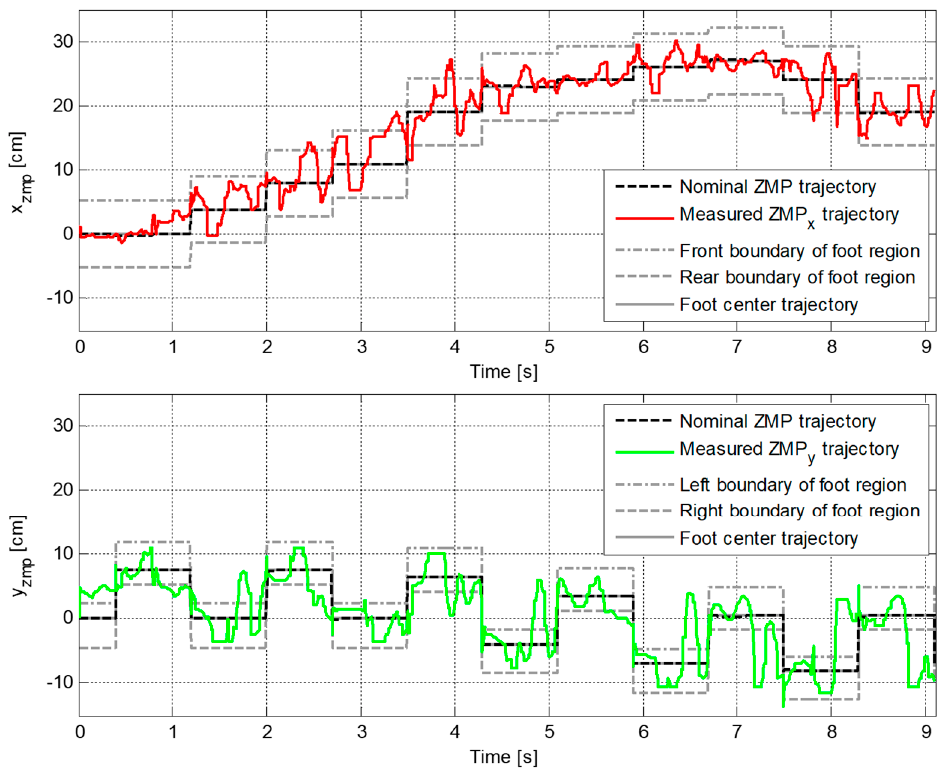
Figure 15. Trajectories of nominal ZMP obtained from the ZMP functions and measured ZMP, 𝐩 (cid:3030) , in the experiment without the walking stability controller.